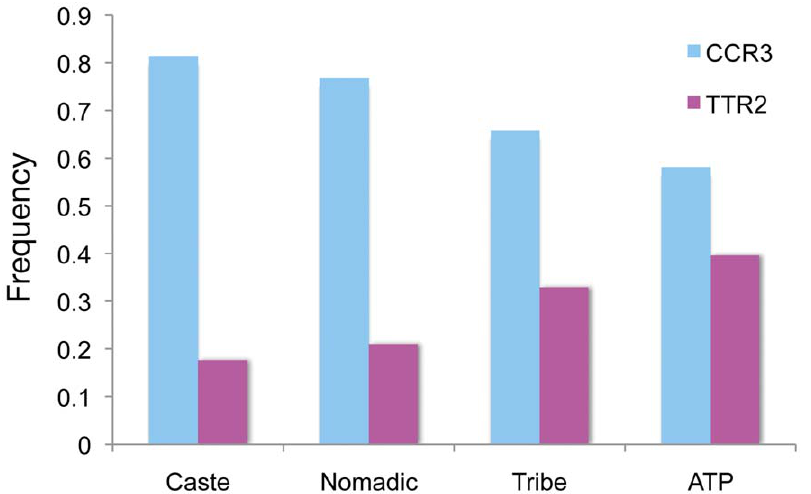
Figure 3. Haplotype distribution among various Indian social groups. The prevalence of protective haplotype TTR2 is significantly higher in ancestral tribal populations.